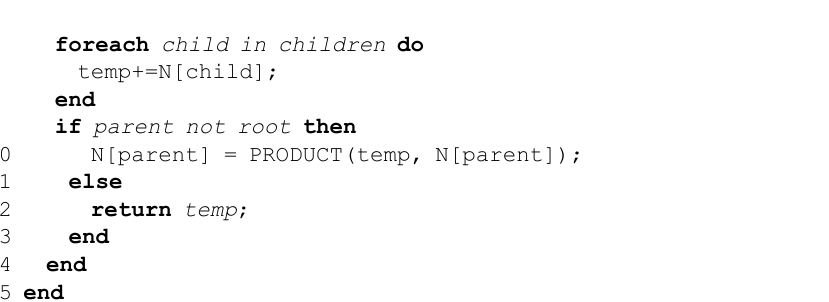
Þ is the inverse Laplace of f ? with i i